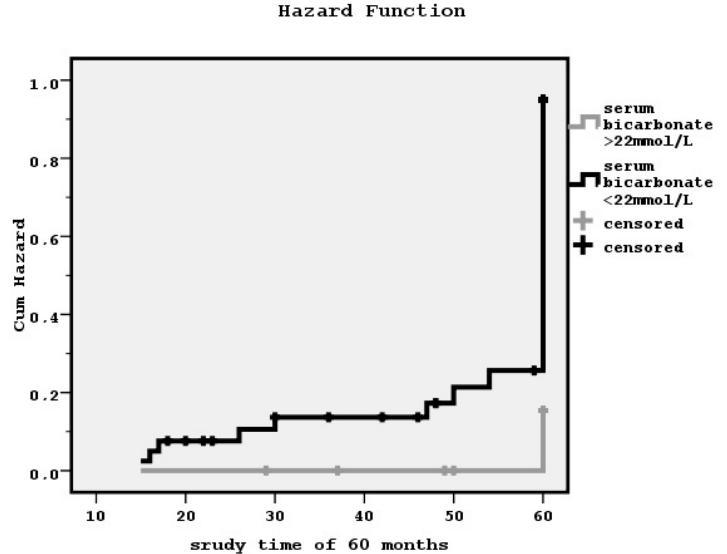
Figure 2. The influence of lower or higher than 22 mmol/L serum bicarbonate levels on peripheral vascular disease manifestation during a follow-up time of 60 months by the Kaplan–Meier curve (log-rank = 5.07, p = 0.02).